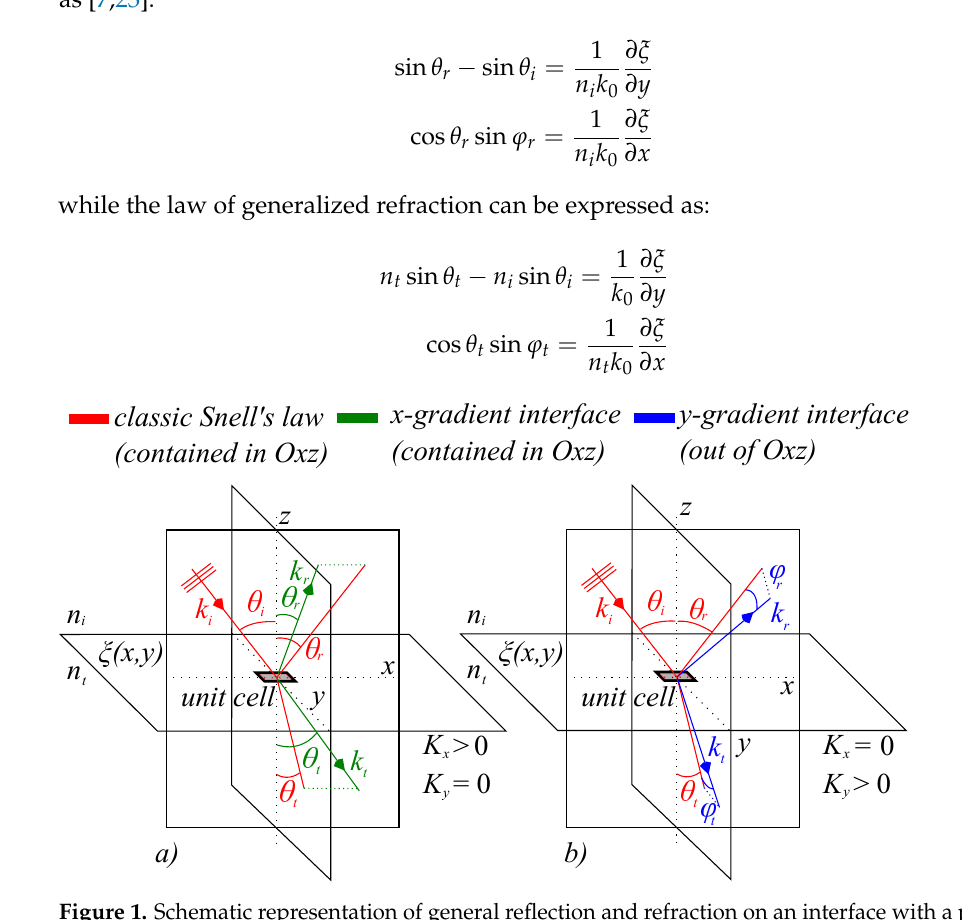
Figure 1. Schematic representation of general reflection and refraction on an interface with a positive- gradient phase distribution. The incident wave is considered a plane wave with a diameter compara- ble with the dimension of the entire interface. The incident wave is contained in the Oxz plane and its wave vector is depicted in solid red. In the classical, zero gradient interface case, the incident, reflected, and refracted waves are contained in the same plane Oxz , with reflection and refraction angles θ r and θ t , respectively. We depict this case in solid red lines. ( a ) For a positive nonzero gradient interface with K x and K y gradients, for K x > 0 and K y = 0, the angles of the reflected and refracted waves will change, but will remain in the incidence plane Oxz . We depict these directions in solid green lines. ( b ) For K y > 0 and K x = 0, the reflected and refracted waves will propagate out of the incidence plane, at angles ϕ r and ϕ t with respect to the directions of the reflected and refracted classical waves. We depict this case in solid blue